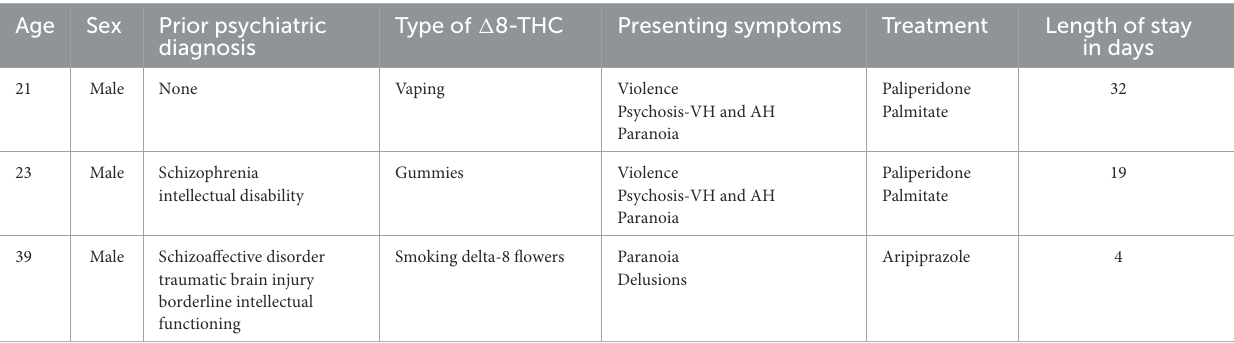
TABLE 1 Summary of